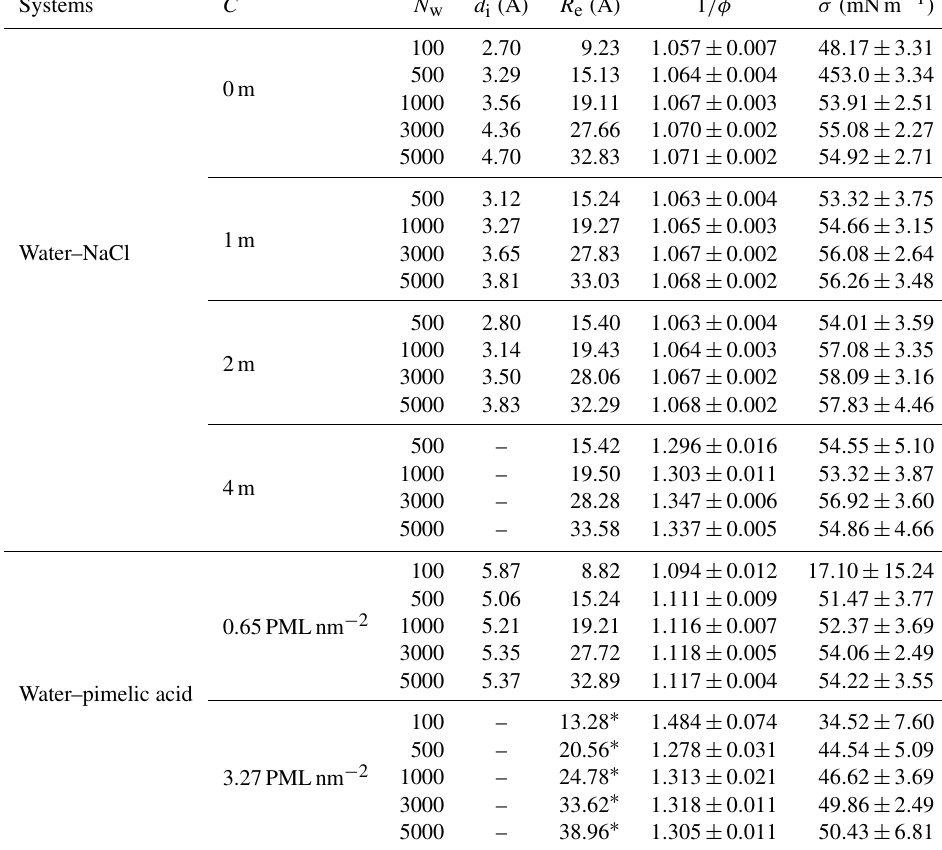
Table A1. Values of equimolar radius ( R e ), interfacial width ( d i ), inverse of the sphericity factor (1 /φ ), and surface tension ( σ ) for water– NaCl mixtures with different ion concentrations ( C ) and for water–pimelic acid droplets with different values of surface organic loading ( C s ) for all simulated systems. R e values were determined from the location of water’s Gibbs dividing surface except where denoted with a ∗ , where they were calculated as [ 3( N w /ρ w + N org /ρ org ) / 4 π ] 1 / 3 using the bulk water density 34 . 02 ± 0 . 19molec.nm − 2 and bulk